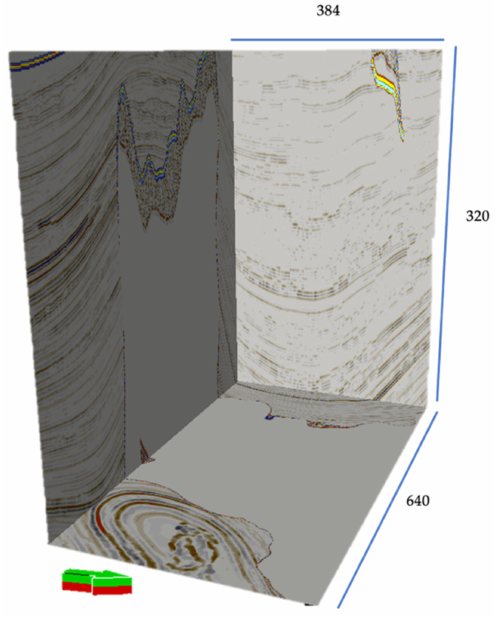
Figure 8. SEAM 3D synthetic data.